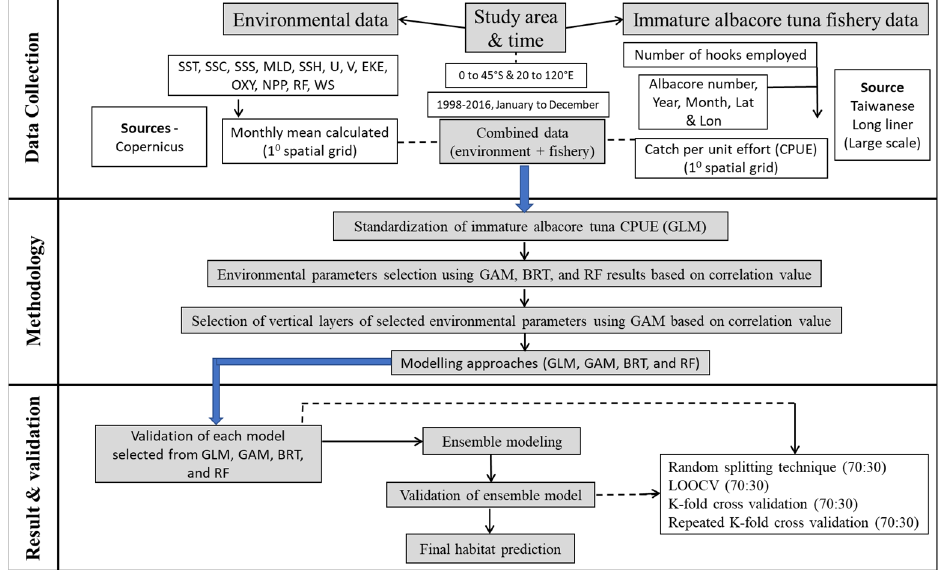
Figure 1. Experimental flowchart.